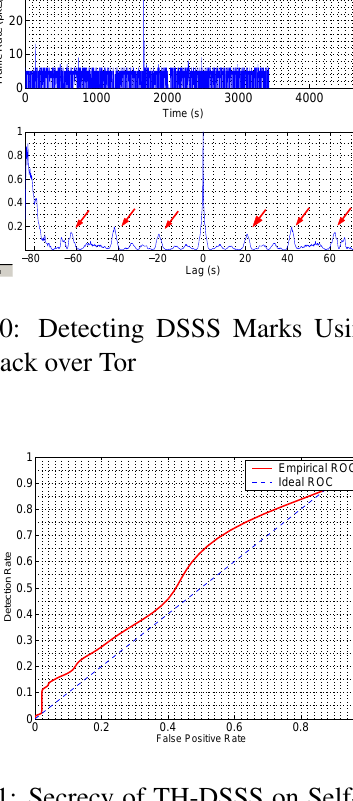
Figure 21: Secrecy of TH-DSSS on Self-Similarity Based Attack over